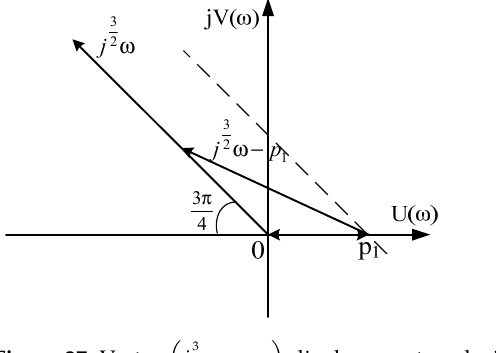
(cid:3119) Figure 27. Vector (cid:4672)𝑗 (cid:3118) 𝜔 − 𝑝 (cid:2869) (cid:4673) displacement analysis for the first root when 𝜔 𝜖 (0, ∞) .